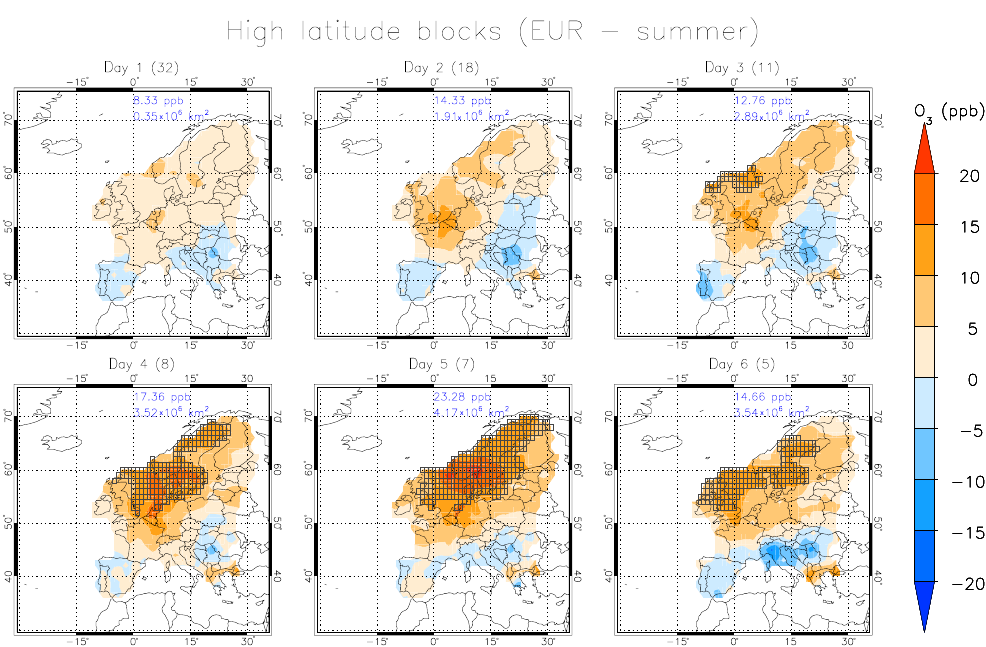
Figure 6. Evolution of MDA8 O 3 anomalies under the influence of EUR blocking in summer. The panels show, from left to right and from top to bottom, the average anomalies on the first six days a block is in the sector. The total number of blocks considered is given in brackets on the top of each panel. The maximum anomaly found (ppb) and the total area with anomalies higher than 5ppb (km 2 ) are also indicated in blue colour. Grey open squares indicate grid cells where the ozone composite under blocking exceeds the 90th percentile of the summer